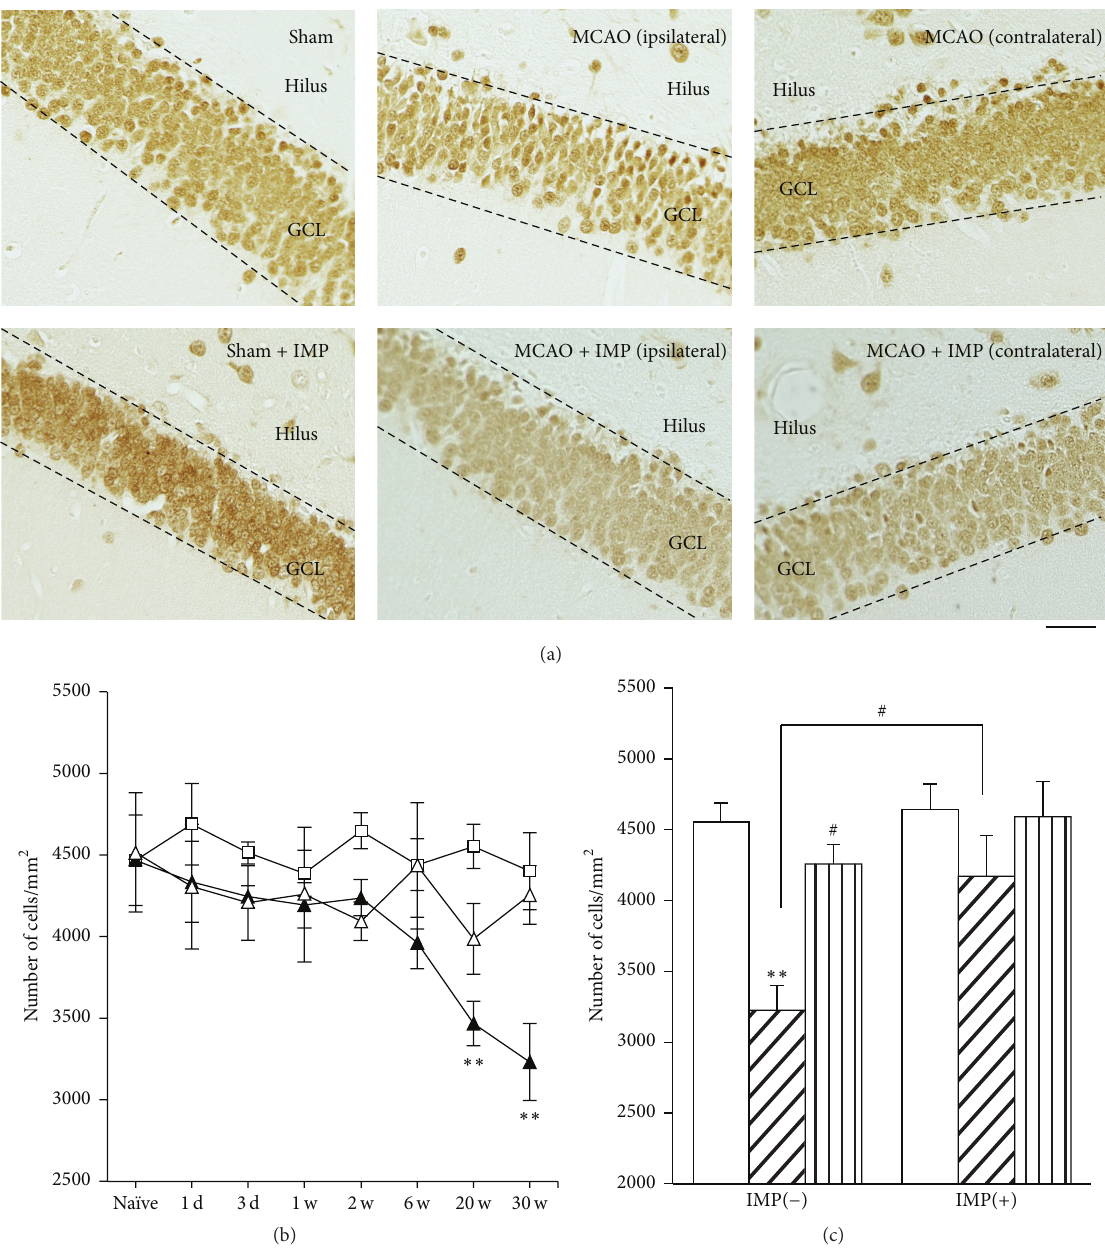
Figure 4: Analysis of NeuN immunopositive cells in GCL. (a) Typical images of the slices taken at 30 weeks after MCAO. Scale bar indicates 50 𝜇 m. (b) Time course changes of NeuN immunopositive cells after MCAO in GCL. Symbols used are as follows: open square, sham; closed triangle, ipsilateral MCAO; open triangle, contralateral MCAO. Statistical significance was evaluated with two-way ANOVA followed by = 2.78 ; 𝐹 = 11.0 ; 𝐹 = 1.57 ; ∗∗ 𝑃 < 0.01 versus sham). (c) Analysis of the Tukey-Kramer test at each time point ( 𝐹 ( ( group )2 ( time ∗ group )14,96 time )7 effect of IMP on the number of NeuN immunopositive cells at 30 weeks after MCAO. Vehicle [IMP( − )] or 20 mg/kg/day of IMP for 29 weeks [IMP(+)] from 1 week after the surgical operation was administered. Statistical significance was evaluated with one-way ANOVA followed by Tukey-Kramer test ( 𝐹 5,24 = 7.00 ; ∗∗ 𝑃 < 0.01 versus sham [IMP( − )]; # 𝑃 < 0.05 versus ipsilateral MCAO [IMP( − )]; 𝑁 = 5 /group).